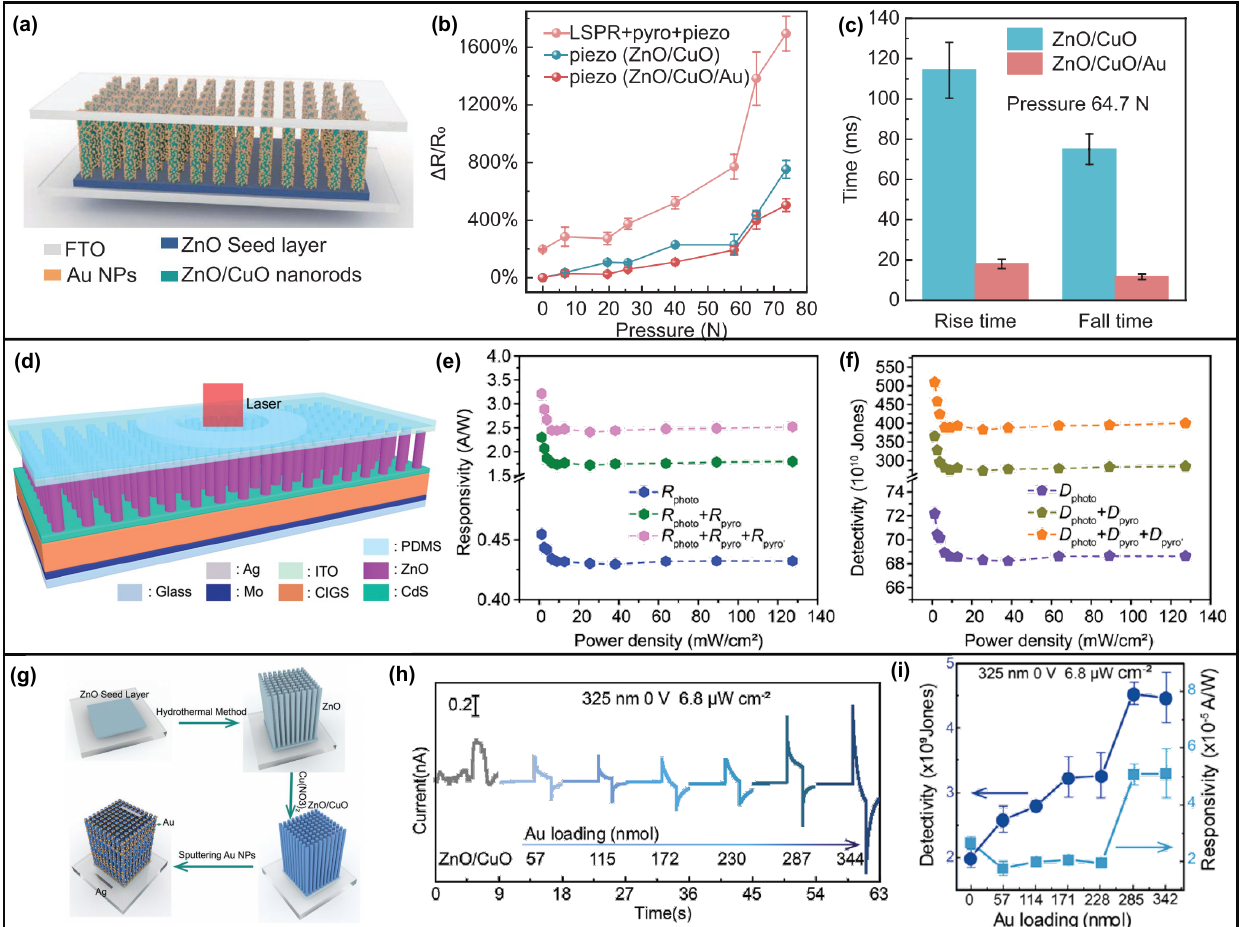
Figure 5. ( a ) Device structure and basic characterization of the self-powered p-CuO/n-ZnO/Au NPs photodetector; ( b ) Δ R / R 0 as a function of different applied pressure for quantitatively comparing the piezo-phototronic effect and the comprehensive effect induced responsivity; ( c ) Response time decrease for coupled LSPR-inspired pyro-phototronic effect and piezo-phototronic effect. Reproduced with permission from [50]. Copyright 2022 Wiley; ( d ) Structural diagram of the Cu(In,Ga)Se 2 multilayer heterojunction photodetector; ( e , f ) Responsivities and detectivities as a function of